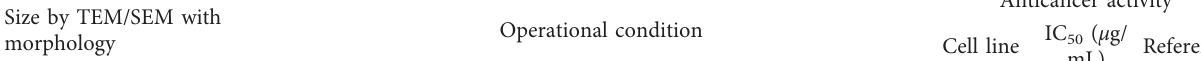
Table 6: Operational condition during synthesis of Ag NPs and their anticancer activity on different cell lines. Size by TEM/SEM with